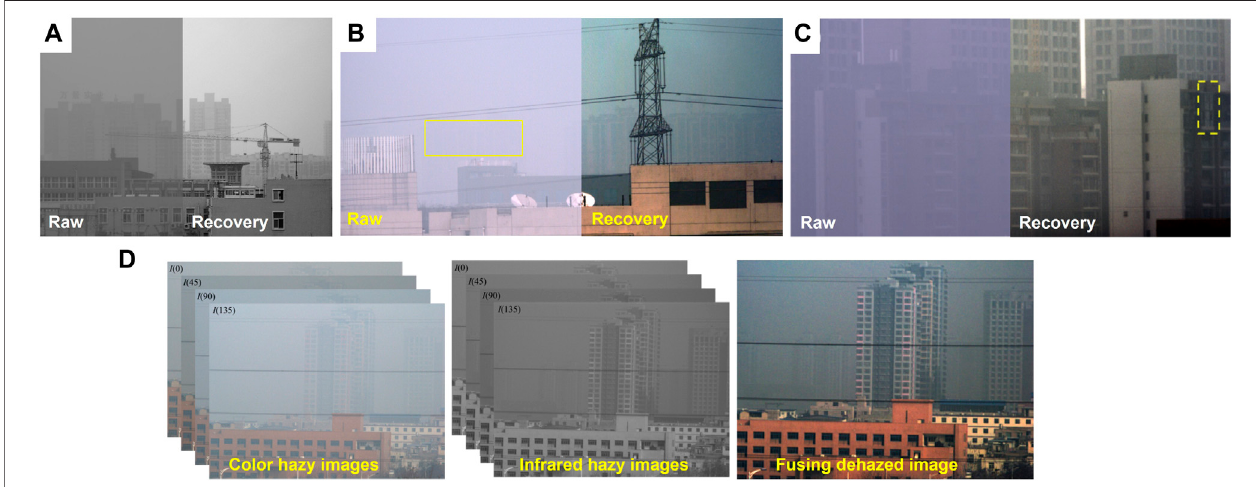
FIGURE 9 | Recovery performance for Liang ’ s methods in Refs. (A) Ref1 (reprint from Chinese Laser Press: Photonics Research [38], copyright 2014). (B) Ref2 (reprint from OSA: Optics Express [43], copyright 2015). (C) Ref3 (reprint from OSA: Optics Express [40], copyright 2021). (D) Ref4 (reprint from OSA: Applied Optics [56], copyright 2016).